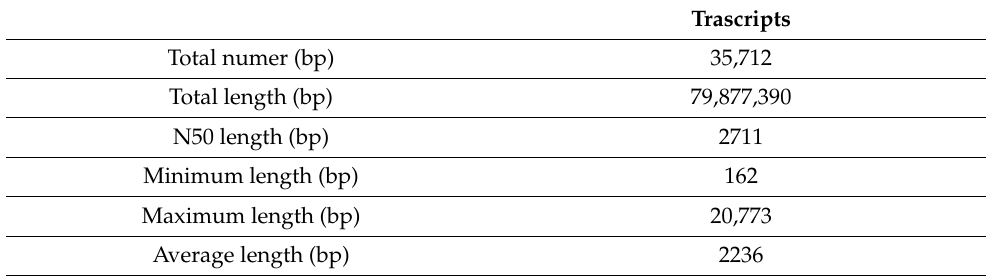
Table 1. Summary of de novo transcriptome data assembly of Cucumis sativus L .